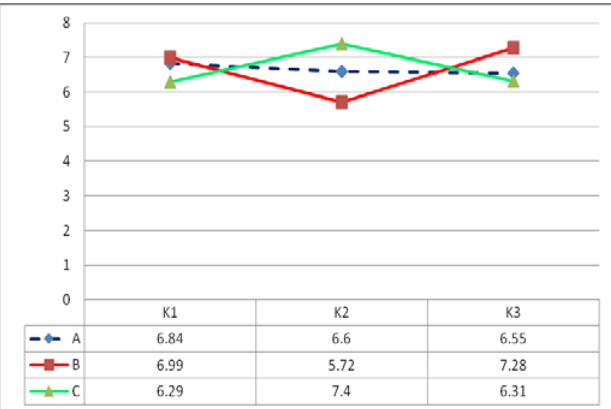
Figure 3: Relationship between the factors, the levels, and the K values (carbon fiber).